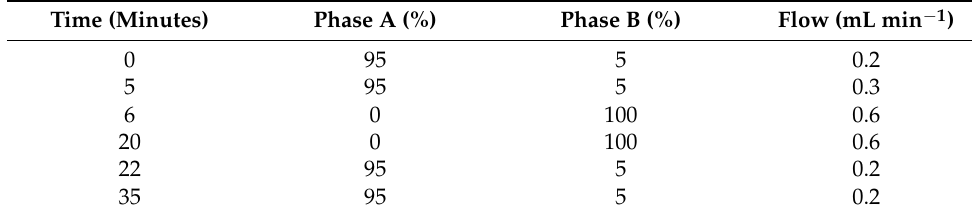
Table 1. Gradient used for chromatographic separation of the first peak. Time (Minutes) Phase A (%) Phase B (%) Flow (mL min − 1 ) 0